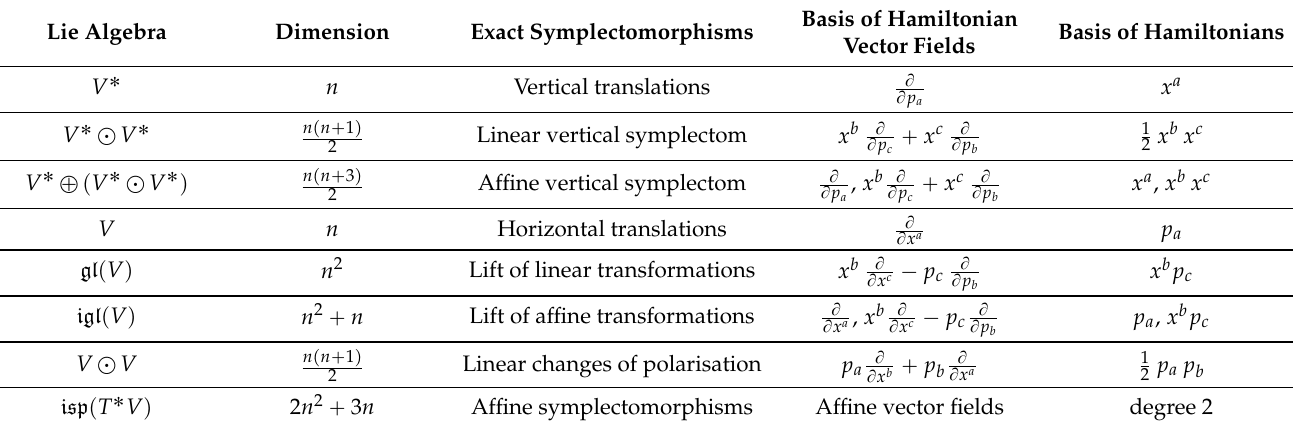
Table 1. Affine symplectomorphisms of the tangent bundle T ˚ V – V ‘ V ˚ of a vector space V of dimension n . Lie